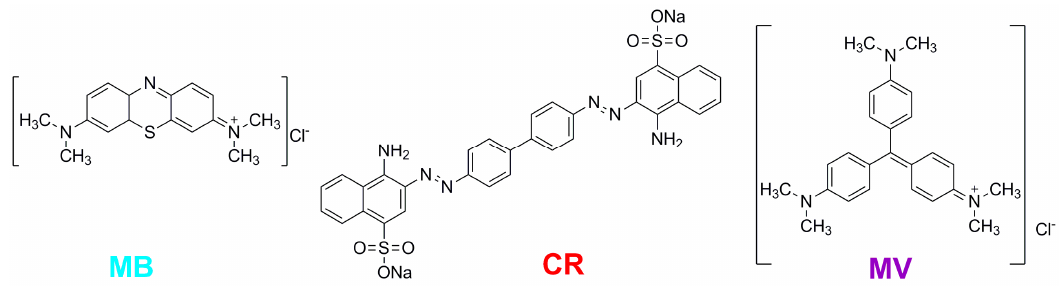
Figure 4. Dye chemical structures.